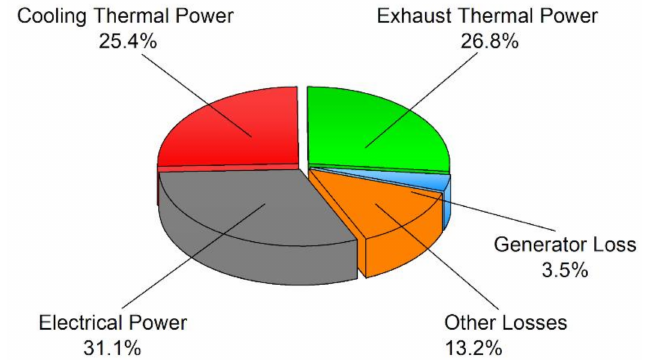
Figure 6. Energy balance of the biodiesel-fired micro-CHP system. The energy utilisation factor was 83.3% and 16.7% of the biodiesel primary energy could not be used for cogeneration purposes, in line with the literature [82,83]. The electric and thermal efficiencies corresponded to 31.1% and 52.2%, respectively. In particular, the useful thermal effect was obtained from the energy exploitation of the cooling fluid and exhaust gas (25.4% and 26.8% of the fuel input,